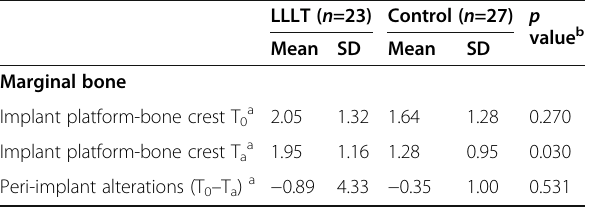
Table 3 Marginal bone alterations compared between LLLT and control